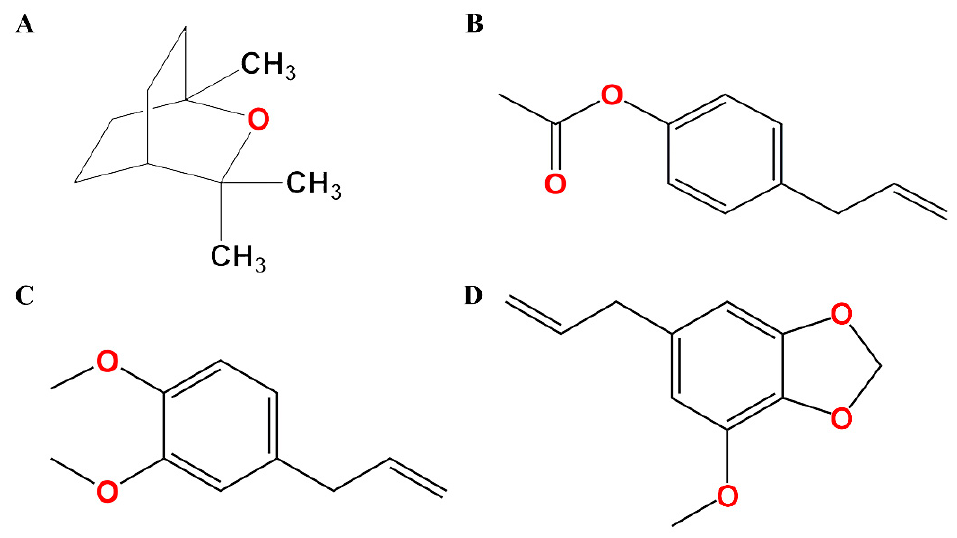
Figure 1. Chemical structures of ( A ) 1,8-cineole, ( B ) 4-allylphenyl acetate, ( C ) methyl eugenol, and ( D ) ( D ) myristicin.